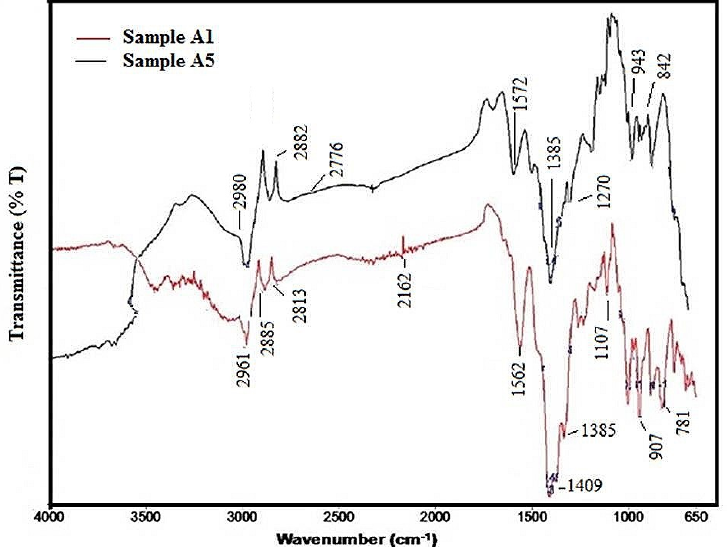
Figure 9. Fourier-transform-infrared (FTIR) spectrometric analysis of samples A1 and A5. FTIR spectra of the sample A5 show that the strong absorption bands at 1572 cm − 1 , 1270 cm − 1 ,